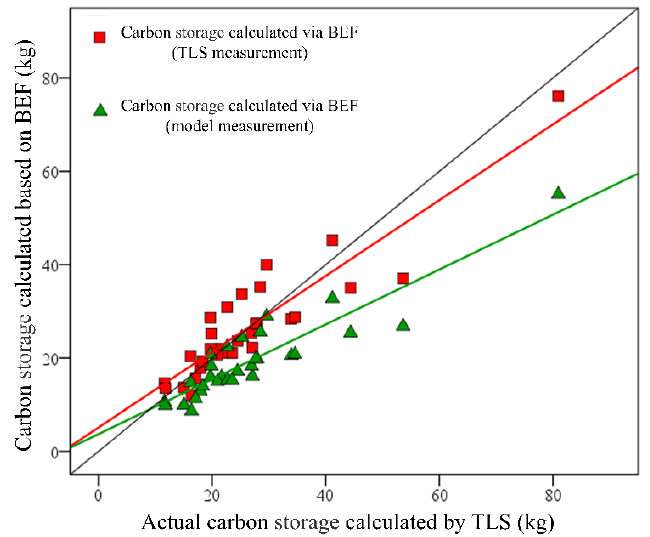
Figure 10. Comparison of carbon stocks based on different BEF measurements.